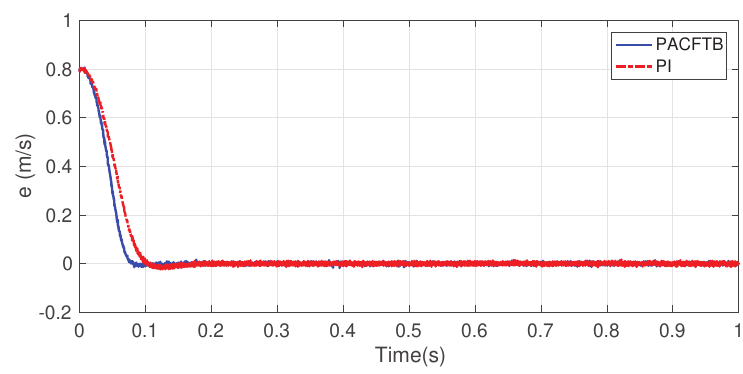
Figure 12. Speed tracking error of